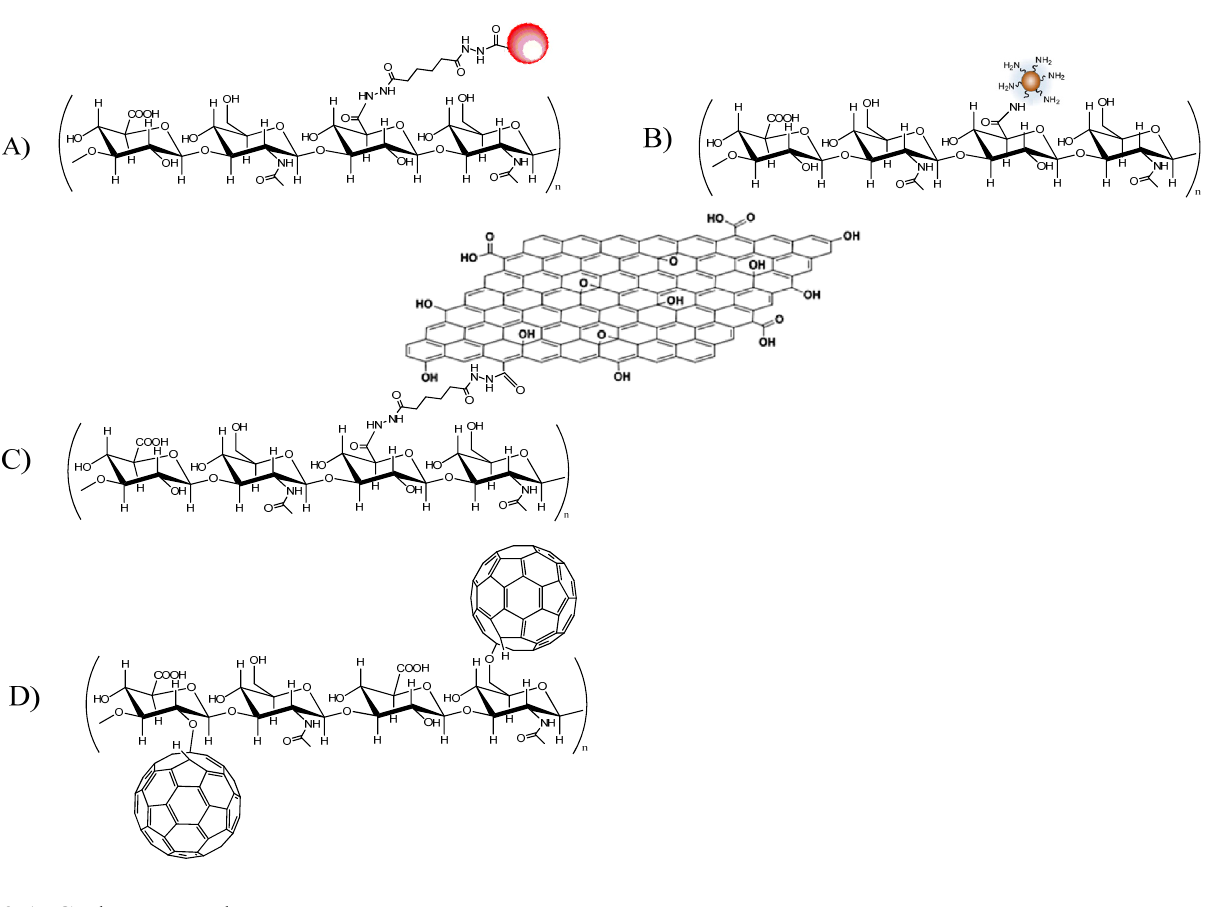
Figure 3. Quantum dots ( A ), carbon nanodots ( B ), graphene oxide ( C ), fullerene ( D ) conjugates with